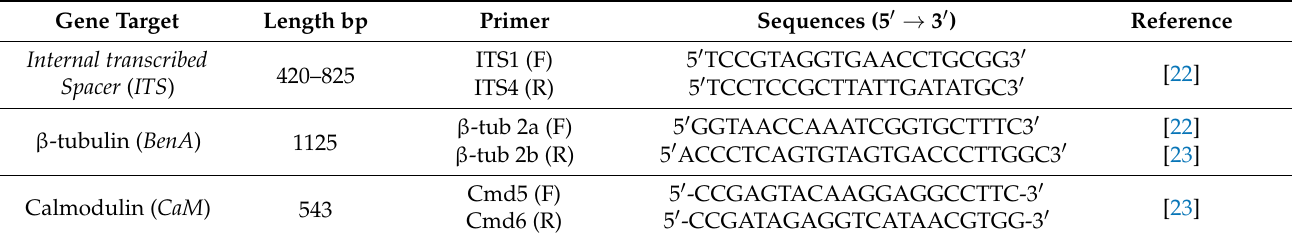
Table 1. Primers used for PCR